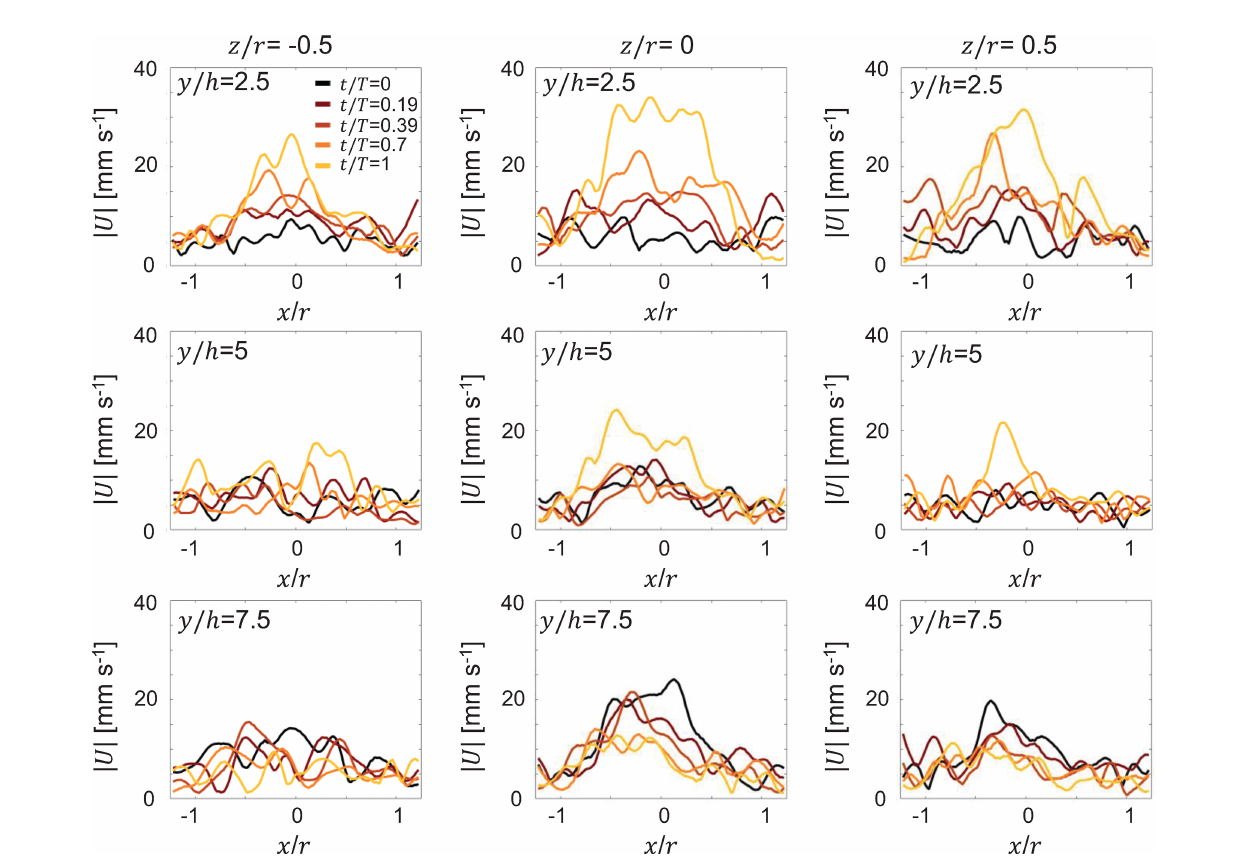
FIGURE 8 | Radial distribution of 3D velocity magnitude (| U |) obtained from 3D PTV measurements on a Cassiopea medusa with no oral arms. Left, middle, and right columns show pro fi les extracted at width-wise locations z / r = -0.5, z / r = 0 and z / r = 0.5, respectively. For each z / r location, velocity pro fi les are shown for 3 height-wise stations y = 2.5 h , y = 5 h and y = 7.5 h . Pro fi les were extracted for the fi rst bell pulsation cycle, during the same non-dimensional times as in Figure 5